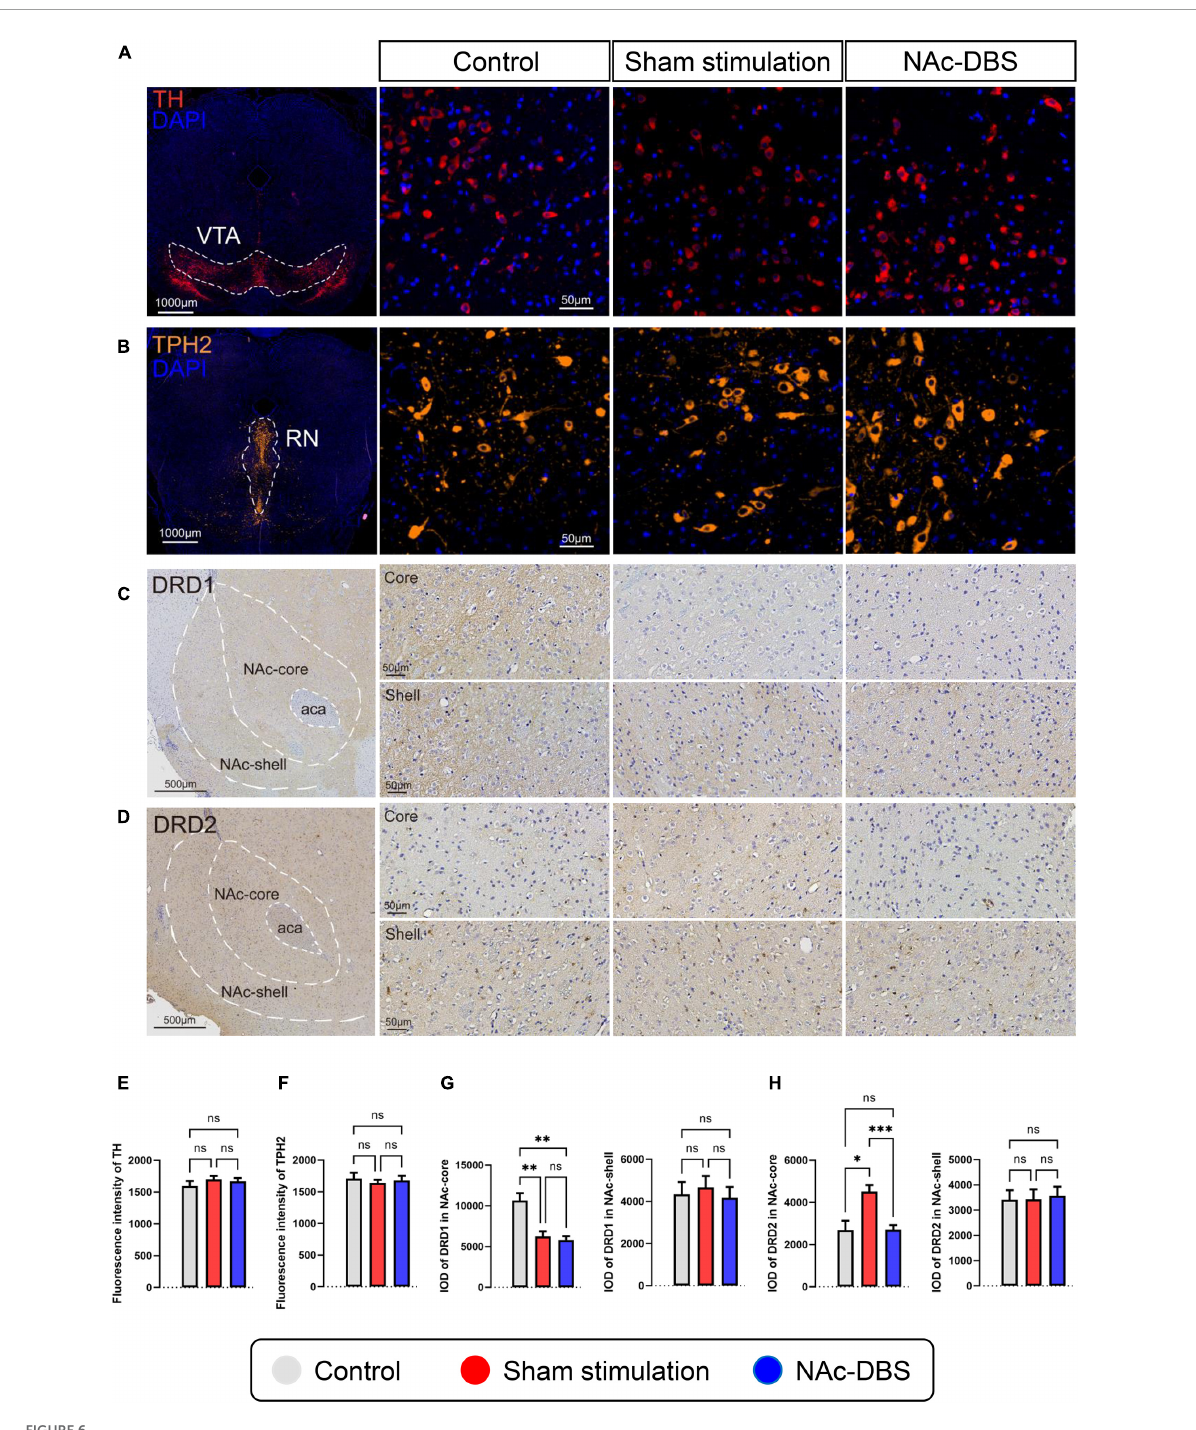
FIGURE6 Differences in pathological sections among the control, sham stimulation and NAc-DBS groups. (A) Immunofluorescence staining for TH was performed to label all dopaminergic neurons in the VTA. (B) Immunofluorescence staining for TPH2 was performed to label all serotonergic neurons in the RN. (C,D) Immunohistochemical staining for DRD1 and DRD2 in the NAc. The top image is the NAc core, and the bottom image is the NAc shell. (E) The bar graph represents the mean level of the immunofluorescence intensity of TH in the VTA. (F) The bar graph represents the mean level of the immunofluorescence intensity of TPH2 in the RN. (G) The bar graphs represent the mean level of IOD of DRD1 in the core and shell of the NAc. (H) The bar graphs represent the mean level of IOD of DRD2 in the core and shell of the NAc. VTA, ventral tegmental area; TH, tyrosine hydroxylase; RN, raphe nuclei; TPH2, tryptophan hydroxylase-2; NAc, nucleus accumbens; DRD1, dopamine receptor-1; DRD2, dopamine receptor-2; IOD, integrated optical density. The data are presented as the mean ± SEM; n = 10 vs. n = 19 vs. n = 19 (immunofluorescence); n = 8 vs. n = 17 vs. n = 15 (immunohistochemistry); ∗∗∗ P < 0.001, ∗∗ P < 0.01, ∗ P < 0.05; ns, no